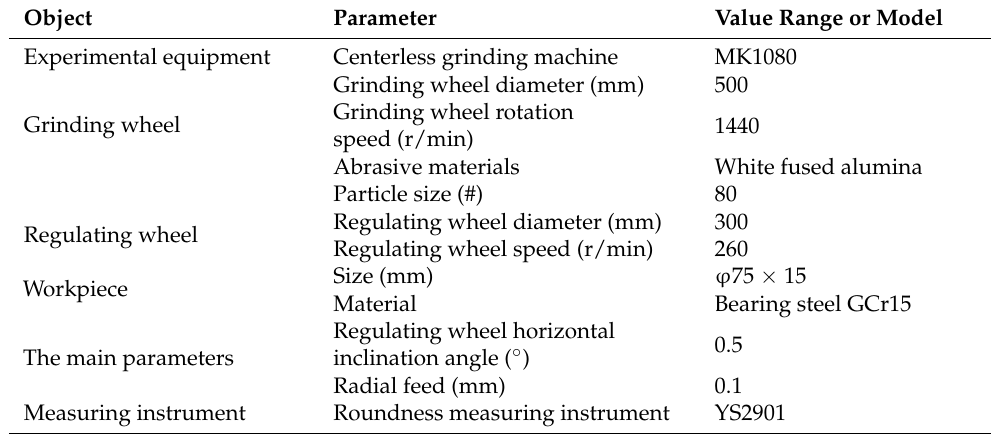
Table 2. Experimental conditions.